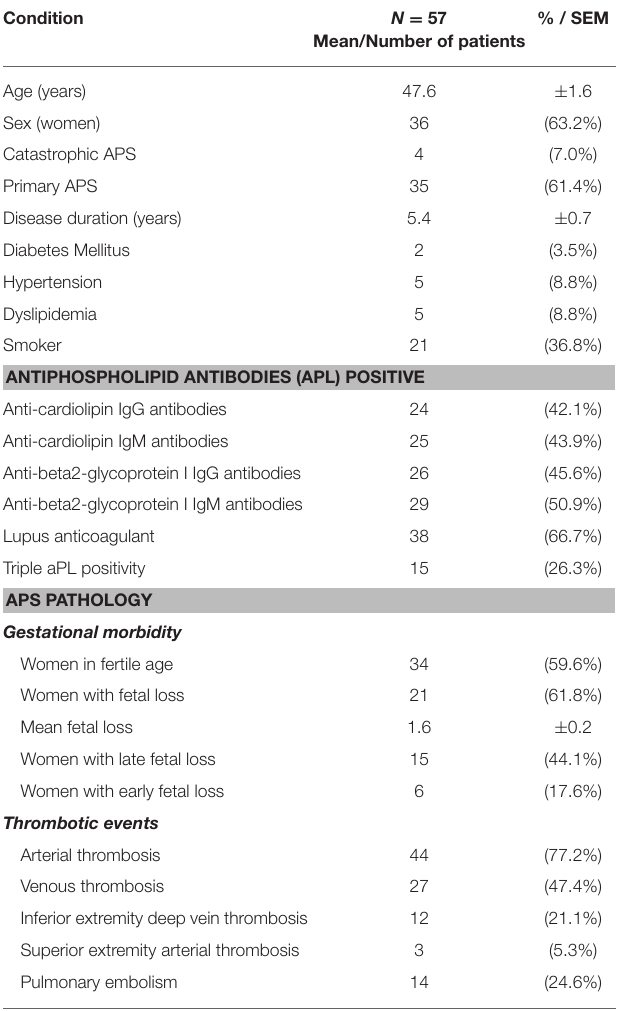
TABLE 1 | Population description and clinical characteristics of the 57 APS patients included in the study.